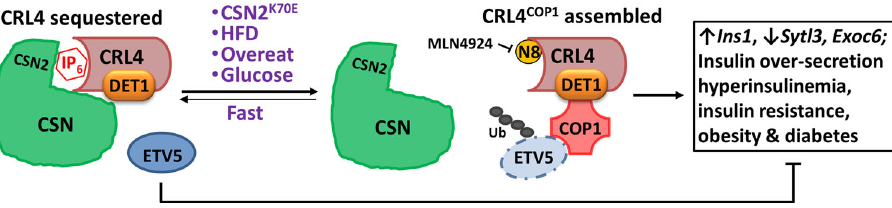
Fig. 8 Scheme depicting the IP 6 – CSN – CRL4 COP1 – ETV5 pathway as a checkpoint controlling insulin secretion and its potential role in the development of diet/overeating-induced obesity and diabetes. CRL4-sequestration by CSN is compromised by CSN2-K70E mutation, or hyperglycemia elicited by nutrient oversupply. This leads to the assembly of CRL4 COP1 E3 ligase to promote ETV5 degradation, which acts as a transcriptional “ brake ” suppressing congenital hyperinsulinemia and consequent